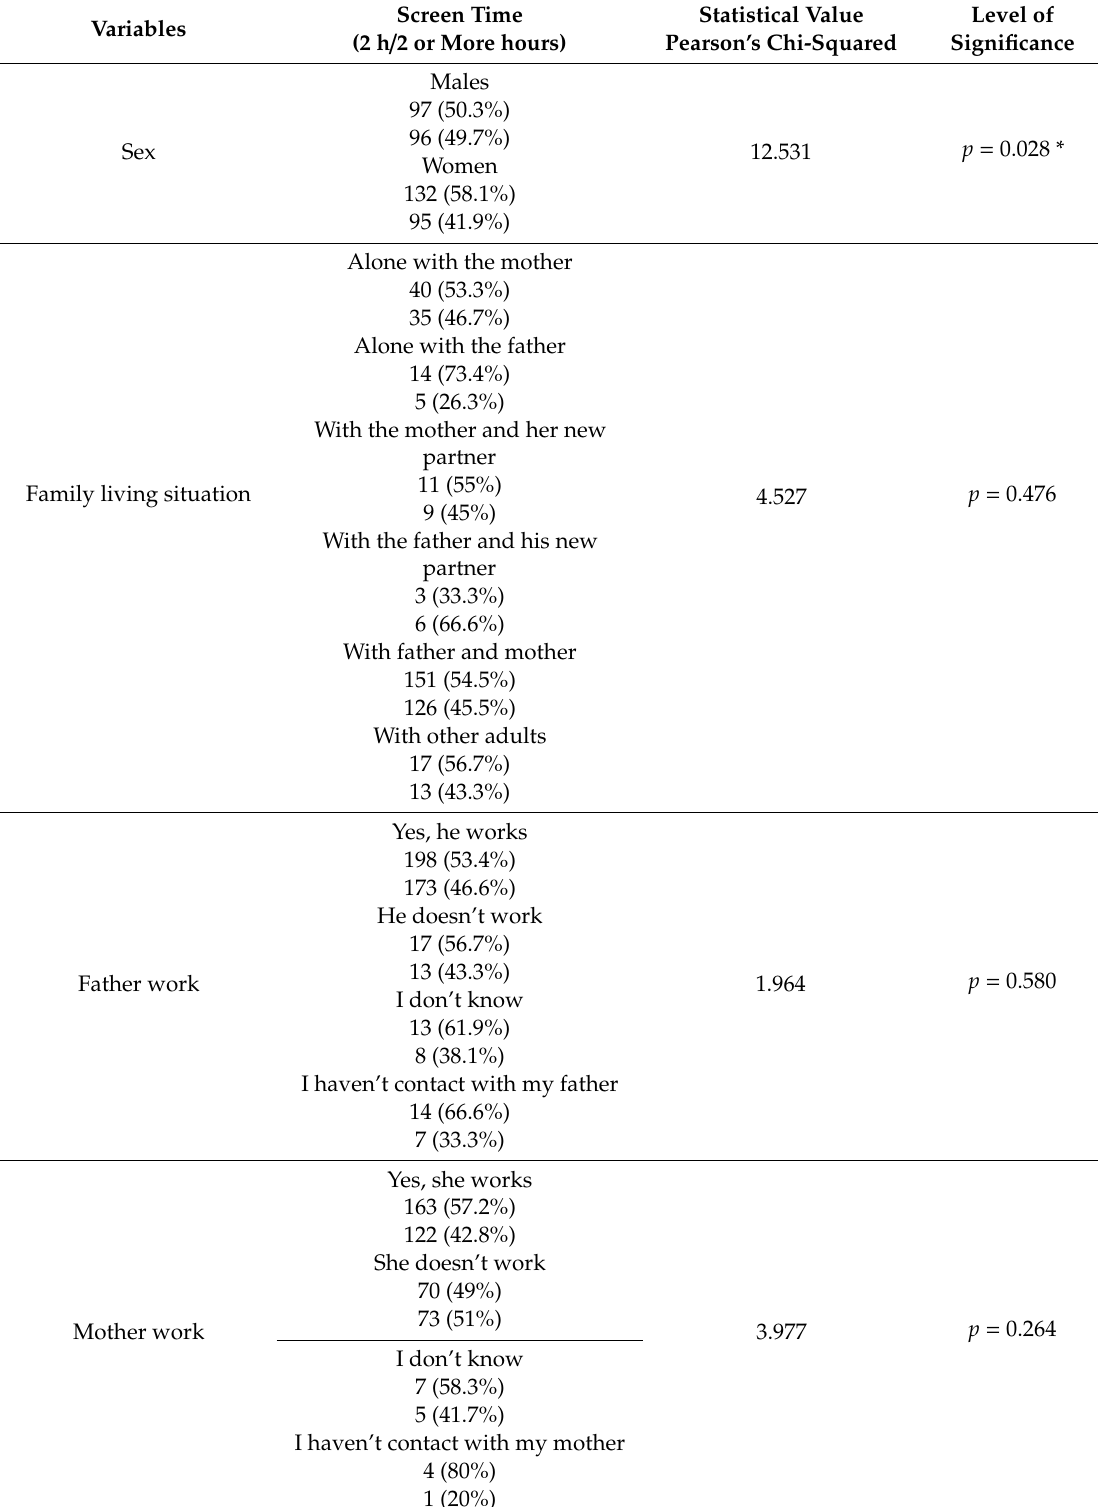
Table 3. Contingency table using the chi-squared